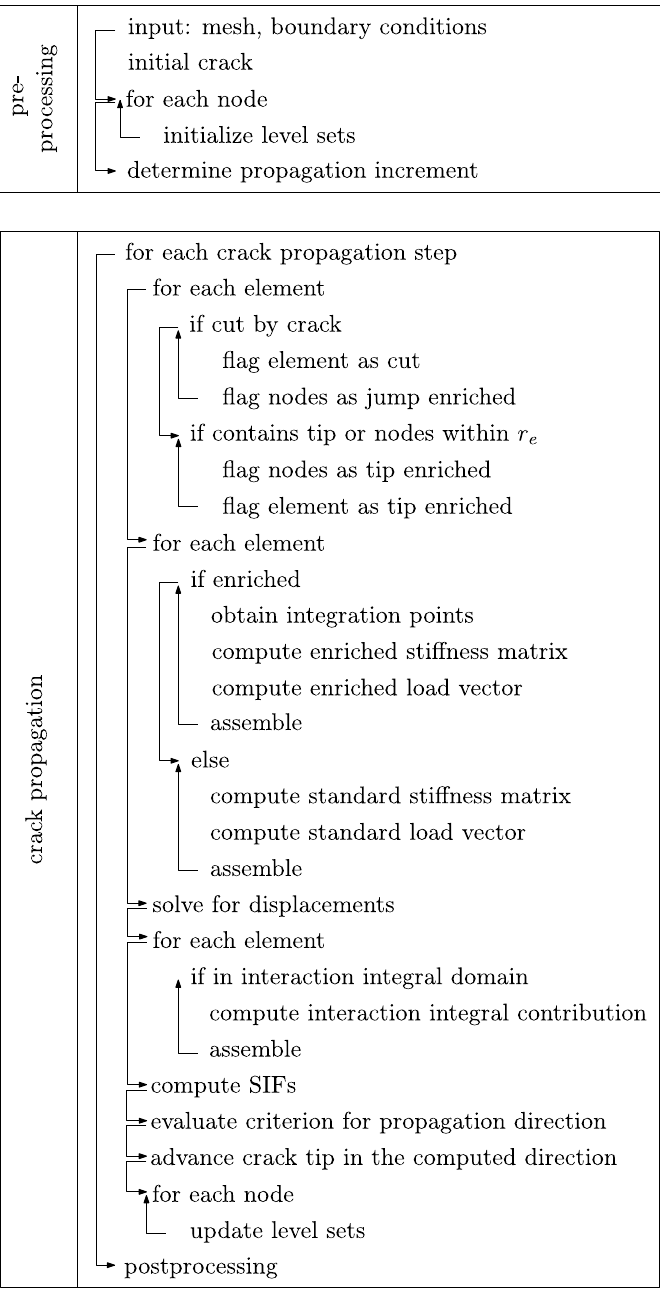
Figure 41. Steps comprising an XFEM/GFEM crack propagation